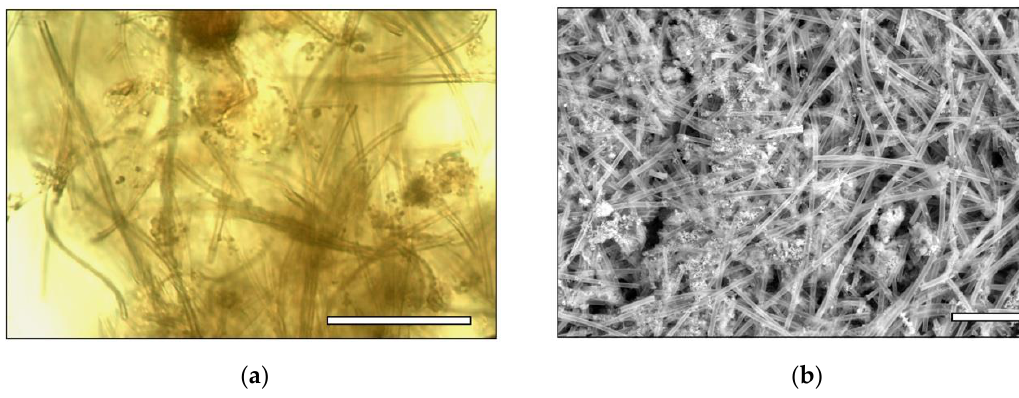
Figure 6. Light micrograph of BIOS suspension with L. ochracea -dominated filamentous sheaths and mineralized hydrous ferric oxide (HFO) particles ( a ) and scanning electron micrograph of dried BIOS ( b ). Both scale bar lengths are 10 µm.